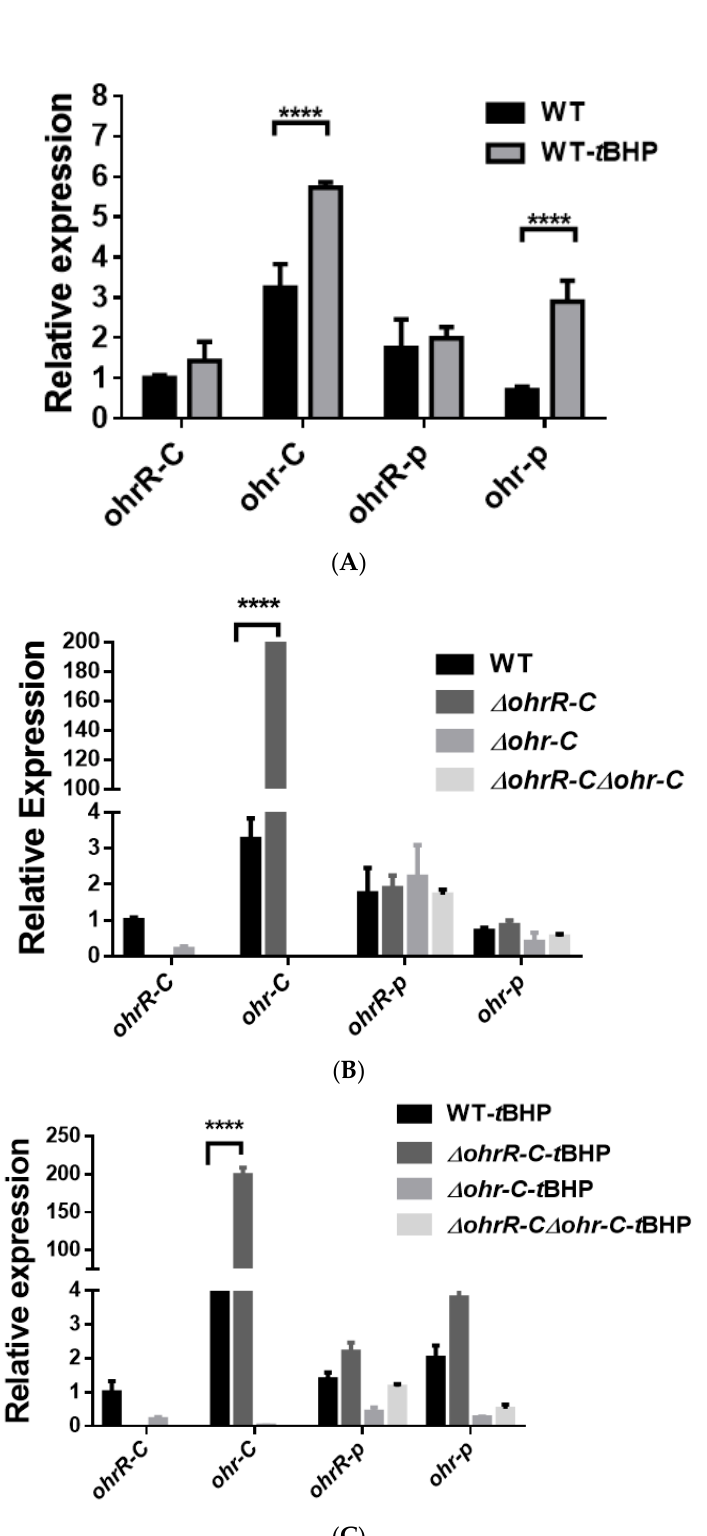
Figure 4. Transcriptional expression of chromosomal ohrR-C-ohr-C and pMAC ohr-p-ohrR-p genes in different strains of A. baumannii ATCC 19606, as quantified by qRT-PCR. ( A ) Relative expression of chromosomal ohrR-C-ohr-C and pMAC ohr-p-ohrR-p genes in wild-type strains cultured in the presence (WT- t BHP) or absence (WT) of 200 μ M of t BHP for 20 min. Relative expression of chromosomal ohrR-C-ohr-C and pMAC ohr-p-ohrR-p genes in ohrR-C mutant ( ∆ ohrR-C ), ohr-C mutant ( ∆ ohr-C ), and ohrR-C-ohr-C double mutant ( ∆ ohrR-C ∆ ohr-C ) strains compared with wild-type strains in the